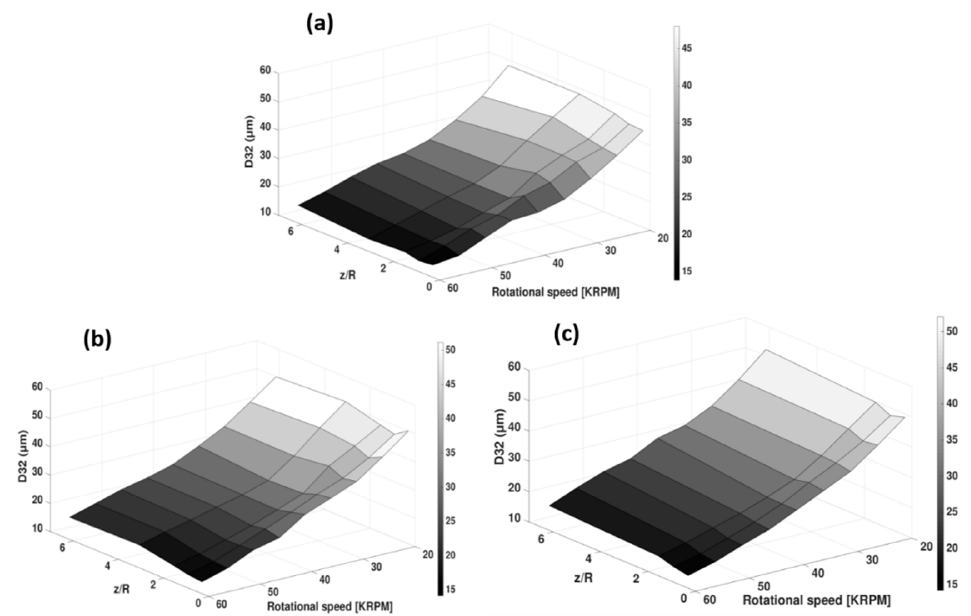
Figure 12. The trend of the behavior of D 32 (in µm) for a different mass flow rate of water of 150 ccm, 250 ccm, and 350 ccm, respectively, as the rotational speeds of the bell cup at five different locations away from the cup on its central axis.